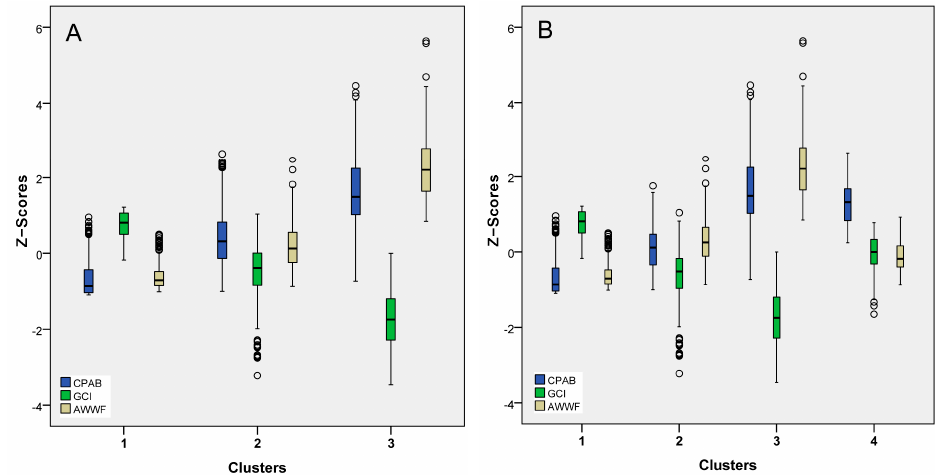
Figure 3. Boxplots for the values of the three fire regime parameters associated with each clustering solution. ( A ) three clusters; ( B ) four clusters. Values expressed as z − scores. For each variable, the box includes the 1st and 3rd quartiles as well as the median. The whiskers identify the maximum and minimum values excluding outliers. Outliers (shown as circles) are defined as values between 1.5 times and 3 times the interquartile range, respectively above the 3rd quartile and below the 1st quartile.